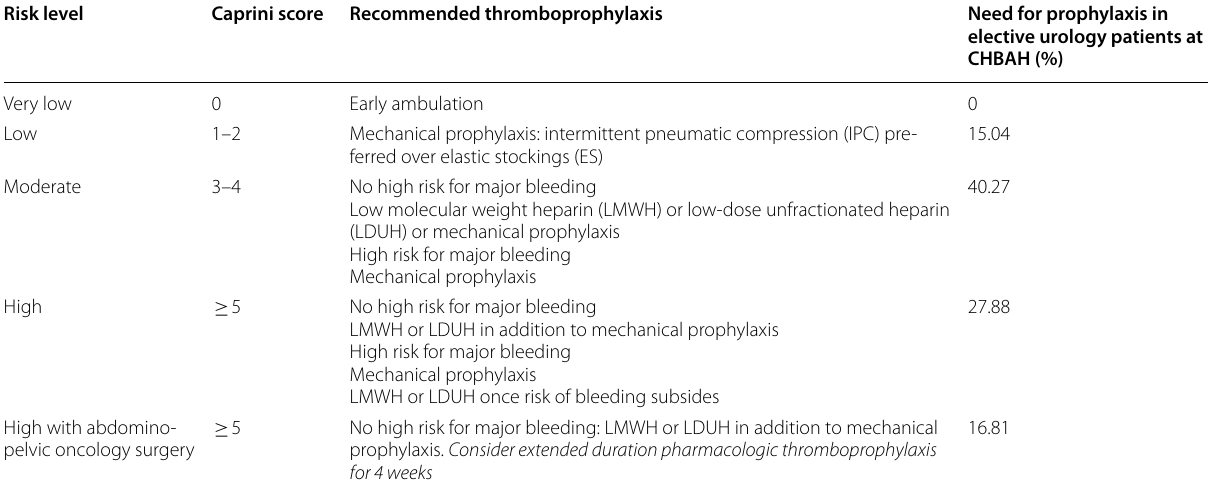
Table 3 Risk levels for VTE and recommended prophylaxis as per ACCP